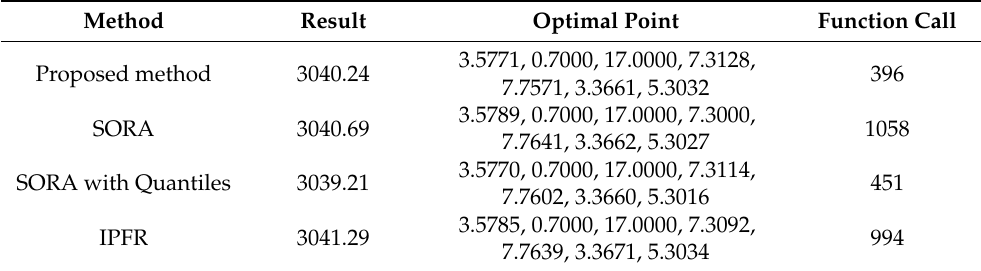
Table 7. Comparison results of the Hock and Schittkowski problem.